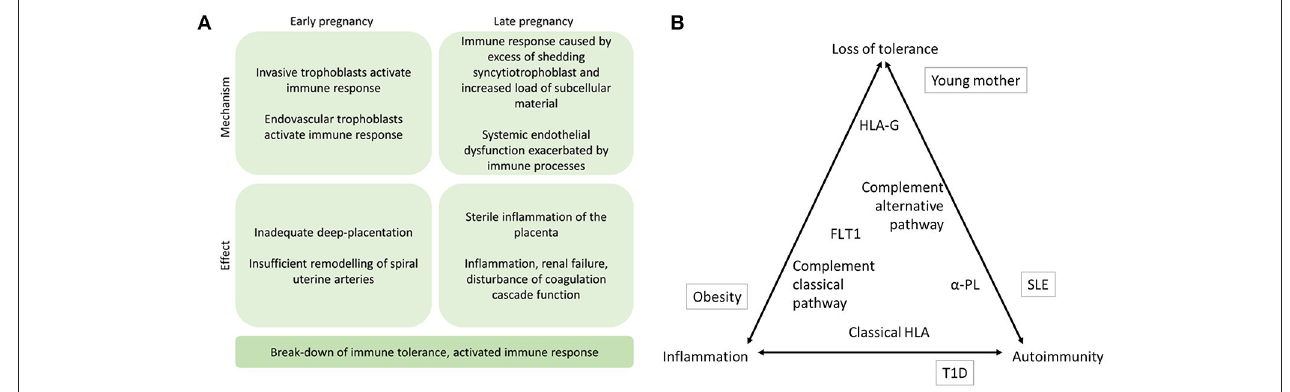
FIGURE 2 | (A) The proposed mechanisms of immune response in the etiology of preeclampsia. Immune mechanisms contribute to preeclampsia in early and late stages of the pregnancy. Specifically, if alternative pathway (AP) of complement system fails to recognize the invading trophoblast cells at the placental bed or in the uterine arteries, placentation may remain superficial and maternal uterine spiral artery remodeling may be compromised. In later stages of the pregnancy, complement activation aiming to facilitate phagosytosis of excess syncytiotrophoblast debris may induce sterile inflammation of the placenta locally. Concurrently, systemic endothelial dysfunction including disturbed coagulation function may be aggravated by immune activation and result in inflammation and shifting of Th2 to Th1 helper cell as well as disturbance of Treg and Th17 cell balances thereby further contributing to activation of the maternal immune response including erroneous antigen presenting in patients with applicable HLA alleles ( 11). (B) The triad of immune mechanisms in preeclampsia. The placement of contributing factors represents their suggested role in contributing to loss of tolerance, inflammation, and autoimmunity. Environmental risk factors outside in boxes, and the immunogenetic factors discussed in this review are inside the triangle. α -PL, anti-phospholipid antibodies; HLA, human leukocyte antigen; FLT1, Fms-like tyrosine kinase 1; T1D, type 1